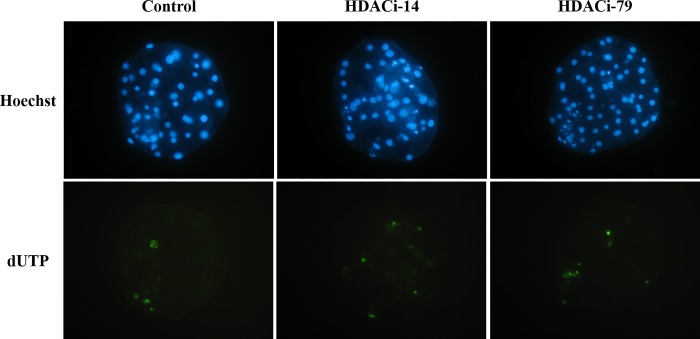
Apoptotic cells of blastocysts from different HDAC trreatments were detected by TUNEL assay.Hoechst staining for the total cell counts; dUTP: Green color represents apoptotic cells. No significant difference was observed among groups (P > 0.05).